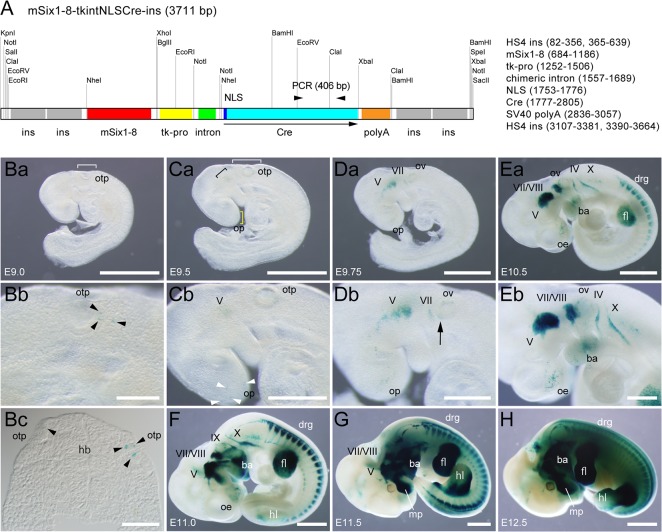
Pattern and specificity of mSix1-8-NLSCre-mediated recombination in embryos.(A) The structure of a transgene used to generate the mSix1-8-NLSCre transgenic mouse line. mSix1-8 (538 bp) is placed upstream of the tkintron (the HSV thymidine kinase gene promoter and chimeric intron) to drive the expression of NLSCre. The polyA signal is from SV40. The entire expression unit is flanked by two tandem copies of the core region of the HS4 insulator (ins). The positions of the genotyping PCR primers (arrowheads) and the size of the PCR product (406 bp) are shown. Selected restriction sites are also indicated. (B-H) Localization of ß-Gal-positive cells in mSix1-8-NLSCre/R26R-LacZ double transgenic embryos. At E9.0 (Ba), the earliest sign of the appearance of ß-Gal-positive cells was detected in the otic pit region (white square bracket). A close-up view (Bb) shows signals in three scattered cells (black arrowheads) in the otic pit. A section through the posterior part of the otic pit confirmed the presence of ß-Gal-positive cells in the pits of both sides (Bc). At E9.5 (Ca), ß-Gal-positive cells were noted in the developing trigeminal ganglion (black square bracket) and olfactory placode (yellow square bracket) in addition to the otic pit (white square bracket). A close-up view (Cb) shows signals in scattered cells in and around the olfactory placode (white arrowheads). At E9.75 (Da), signals were detected in the developing geniculate ganglion. In a close-up view (Db) showed signals in the ventral portion of the otic vesicle (black arrow). At E10.5 (Ea), clear signals were detected in all the cranial sensory ganglia (V, VII, VIII, IX and X), cells in and around the olfactory epithelium (Eb, a close-up view) and in the DRG. At E11.0 (F), the intensity of the signals in the sensory organs became stronger. Signals were also found in the mesenchyme of forelimb bud (Ea, F-H), hindlimb bud (F-H), branchial arches (Ea, Eb, F-H), and the maxillary process (F-H). In all panels of whole mount embryos, anterior is to the left, dorsal is to the top, and all panels are lateral views. In the transverse section shown in Bc, dorsal is to the top. ba: branchial arches, drg: dorsal root ganglia, fb: forebrain, fl: forelimb bud, hb: hindbrain, hl: hindlimb bud, mp: maxillary process, oe: olfactory epithelium, op: olfactory placode, otp: otic pit, ov: otic vesicle, V: trigeminal ganglia, VII: geniculate ganglia, VII/VIII: VII/VIII ganglion complex, IX: petrosal ganglion, X: nodose ganglion. Scale bars: 2 mm (H), 1 mm (Ba, Ca, Da, Ea, F, G), 0.2 mm (Bb), 0.5 mm (Cb, Db, Eb), 0.1 mm (Bc).